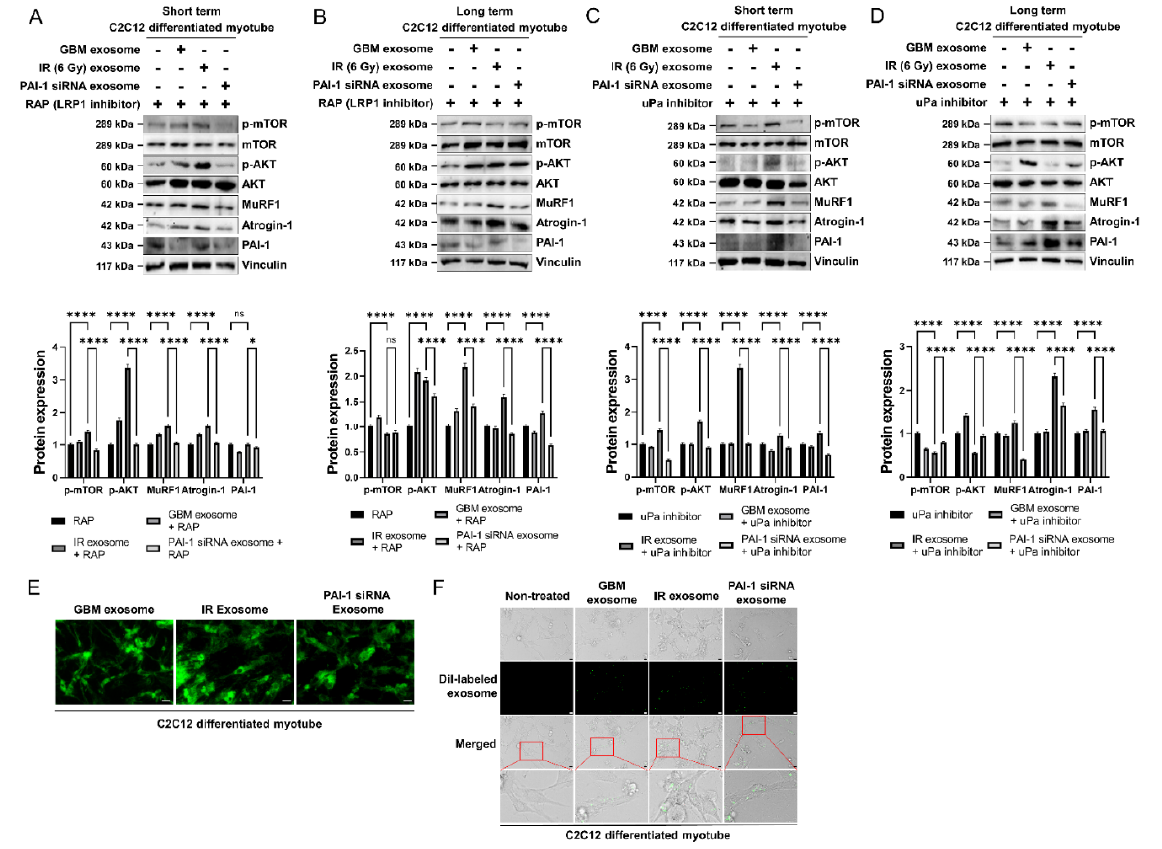
Figure 5. Exosomal PAI-1 was directly penetrated via non-receptor-mediated endocytosis in differ- entiated myotubes. ( A , B ) The protein expression of muscle protein synthesis (p-mTOR, p-AKT), muscle protein degradation (MuRF1, Atrogin-1) related proteins, and the PAI-1 protein in C2C12 differentiated myotube treated with the U87MG exosome and LRP1 inhibitor (RAP) in the short-term or long-term were assessed by western blot (upper panel). p-mTOR, p-AKT, MuRF1, Atrogin-1, PAI-1 protein were quantified (lower panel). ( C , D ) The protein expression of muscle protein synthesis (p-mTOR, p-AKT), muscle protein degradation (MuRF1, Atrogin-1) related proteins, and the PAI-1 protein in C2C12 differentiated myotube treated with U87MG exosome and uPA inhibitor in the short-term or long-term were assessed by western blot (upper panel). p-mTOR, p-AKT, MuRF1, Atrogin-1, PAI-1 protein were quantified (lower panel). ( E ) Fluorescence imaging of C2C12 differenti- ated myotube cells treated with U87MG exosome contained with PAI-1-GFP protein. Scale bar, 10 µ m. ( F ) Take DiO-labeled U87MG exosomes and C2C12 differentiated myotube cells to co-culture for 24 h, cellular uptake of exosomes detected by fluorescence microscope Scale bar, 10 µ m. Statistical analysis was performed with one-way ANOVA plus Tukey’s multiple comparisons test. ns: nonsignificant, * p < 0.05, **** p <